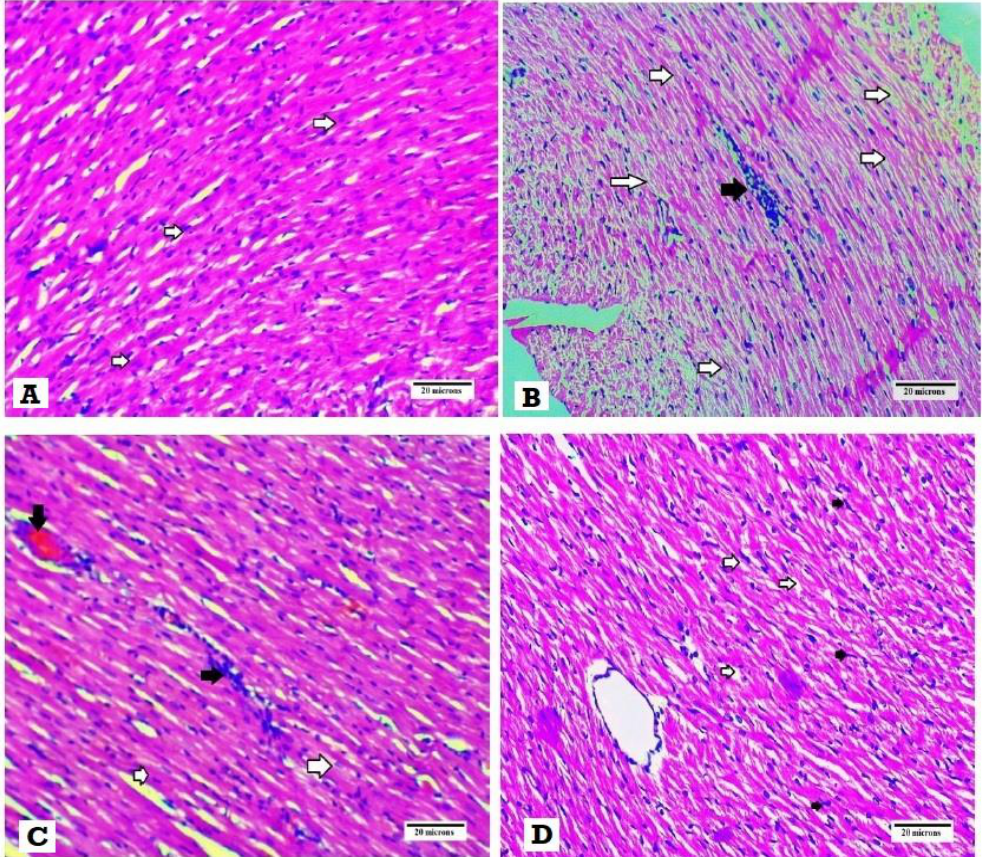
Figure 3. Histopathological examination of the heart tissues stained with H&E. ( A ) Heart specimen from control group showing regularly arranged cardiomyocytes and their nuclei (white arrows) (400×), ( B ) heart specimen from the DM group showing disarranged swollen cardiomyocytes with deformed nuclei of cardiomyocytes and wide myocardial gap (white arrows) and inflammatory cells infiltrate (black arrows) (400×), ( C ) heart specimen from the DM + GLP1 group showing minimal interstitial edema and deformed nuclei of cardiomyocytes ) white arrows), inflammatory infiltrate (black arrows) and interstitial hemorrhage (black arrow) (400×), and ( D ) heart specimen from the DM+ SGLT2i group showing regular arrangement of cardiomyocytes with regular arranged nuclei (black arrow) with minimal widening of myocardial gap (400×).